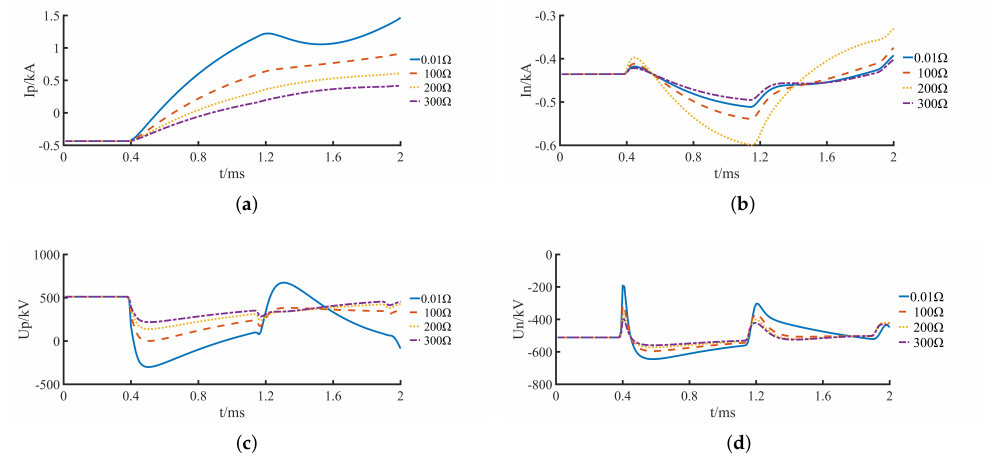
Figure 6. The PG fault waveforms under different transition resistance of the 50% Line MN. ( a ) The fault waveforms of Ip; ( b ) The fault waveforms of In; ( c ) The fault waveforms of Up; ( d ) The fault waveforms of